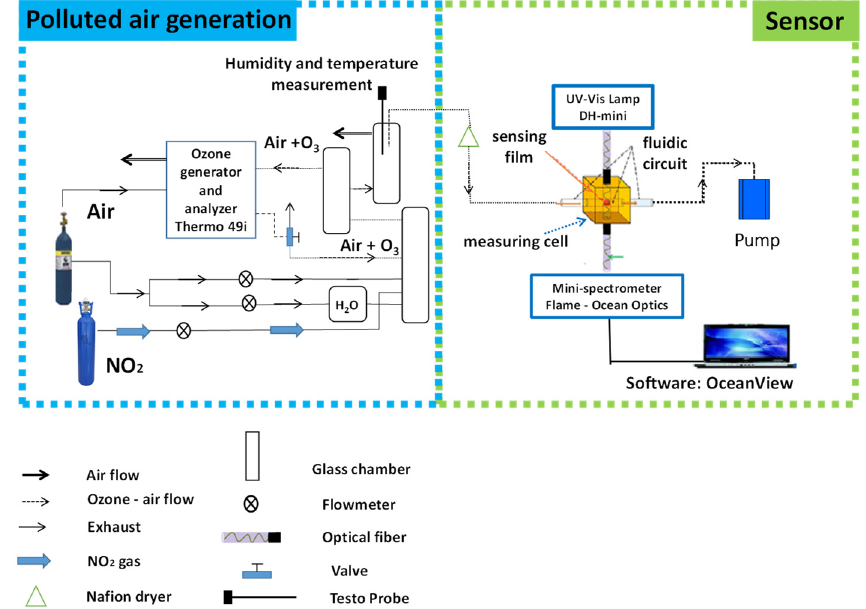
Figure 2. Schematic diagram of the experimental setup.